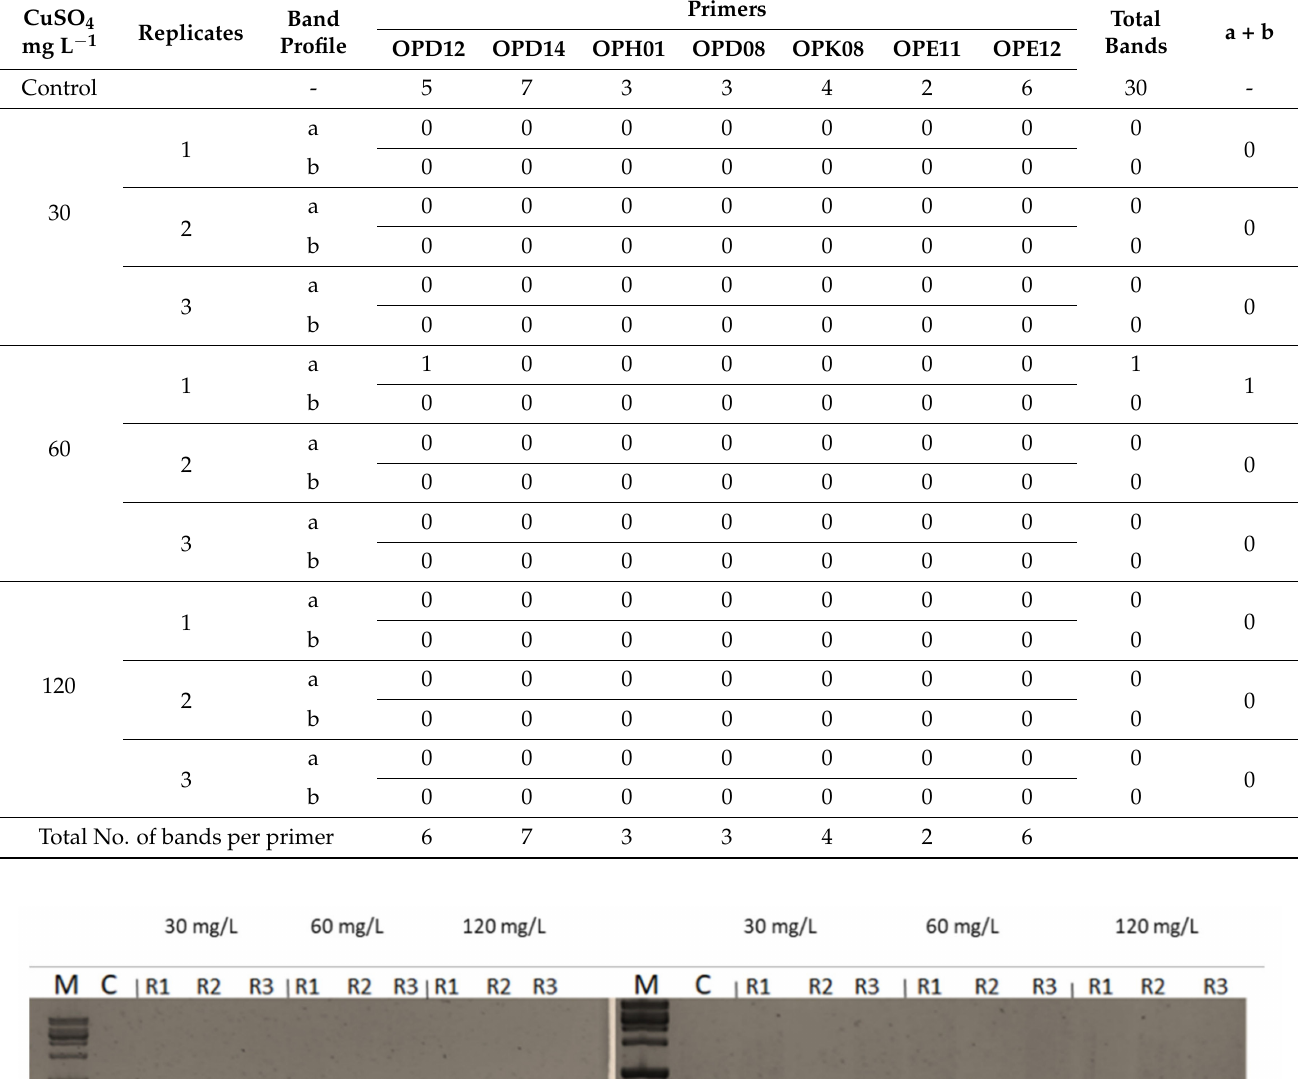
Table 7. RAPD band patterns generated from genomic DNA of copper sulphate-treated and control banana in vitro plants. CuSO 4 Replicates mg L − 1